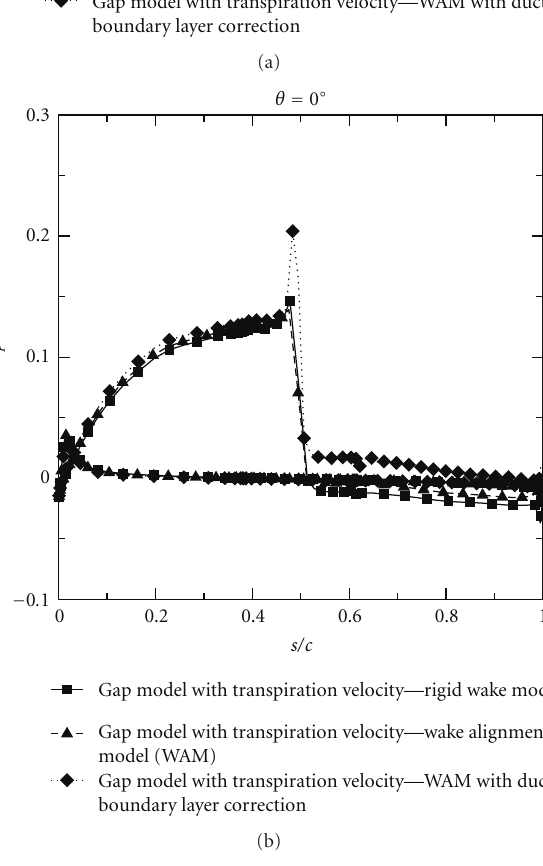
Figure 12: Blade chordwise pressure distribution at r/R = 0 . 95 (a). Duct chordwise pressure distribution at θ = 0 degrees (b). Influence of wake model. Ka4-70 inside duct 19Am at J = 0 . 5. Gap model with transpiration velocity.